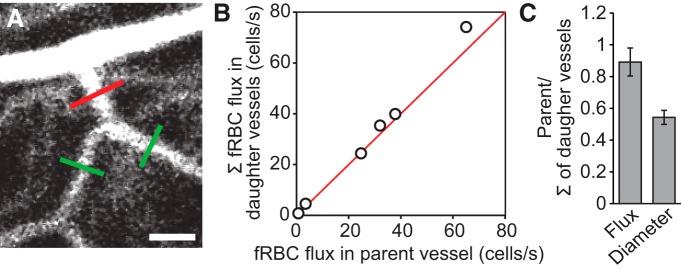
RBC flux and diameter at vessel bifurcations. A, Confocal reference image showing a typical bifurcation. The red line represents the confocal line scan across the parent vessel, and the green lines represent the line scans across the two daughter vessels. Scale bar, 40 µm. B, The mean RBC flux for the parent vessel is plotted against the sum of RBC fluxes in the daughter vessels for six bifurcating vessels. The red line represents unity. C, The ratio of the parent to the sum of daughter vessels for RBC flux and vessel diameter.